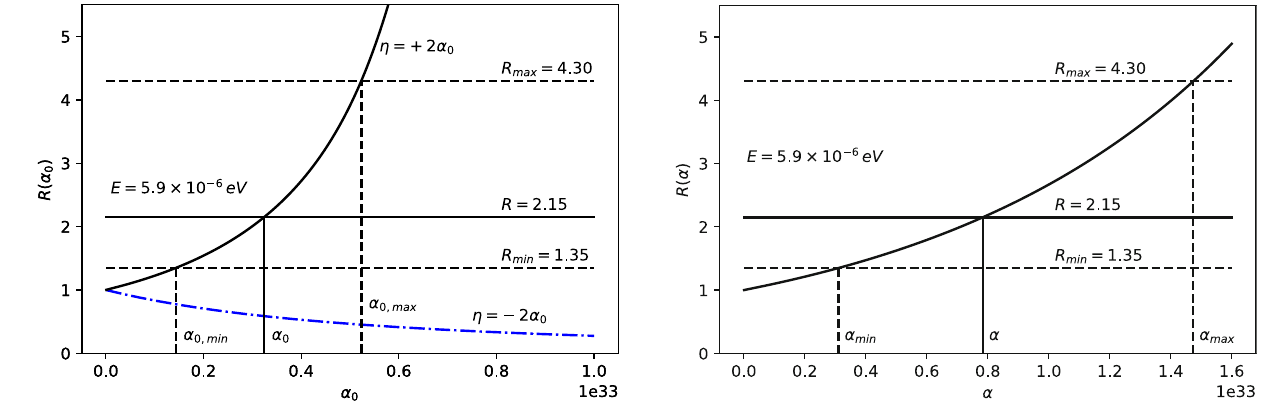
Fig. 2 R vs α 0 for fixed energy E = E 12 (cid:2) 5 . 9 × 10 − 6 eV. The η = − 2 α 0 branch is presented in dash-dot blue and the branch is presented in solid black